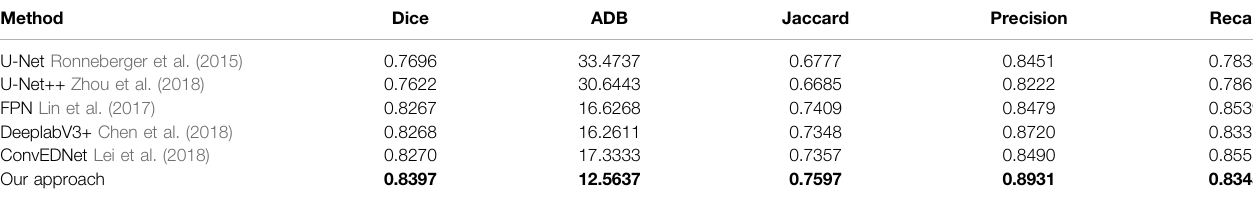
TABLE 2 | Measurement results of different segmentation methods on the BUSI dataset. Our results are highlighted in bold. Method Dice ADB Jaccard Precision Recall U-Net Ronneberger et al.